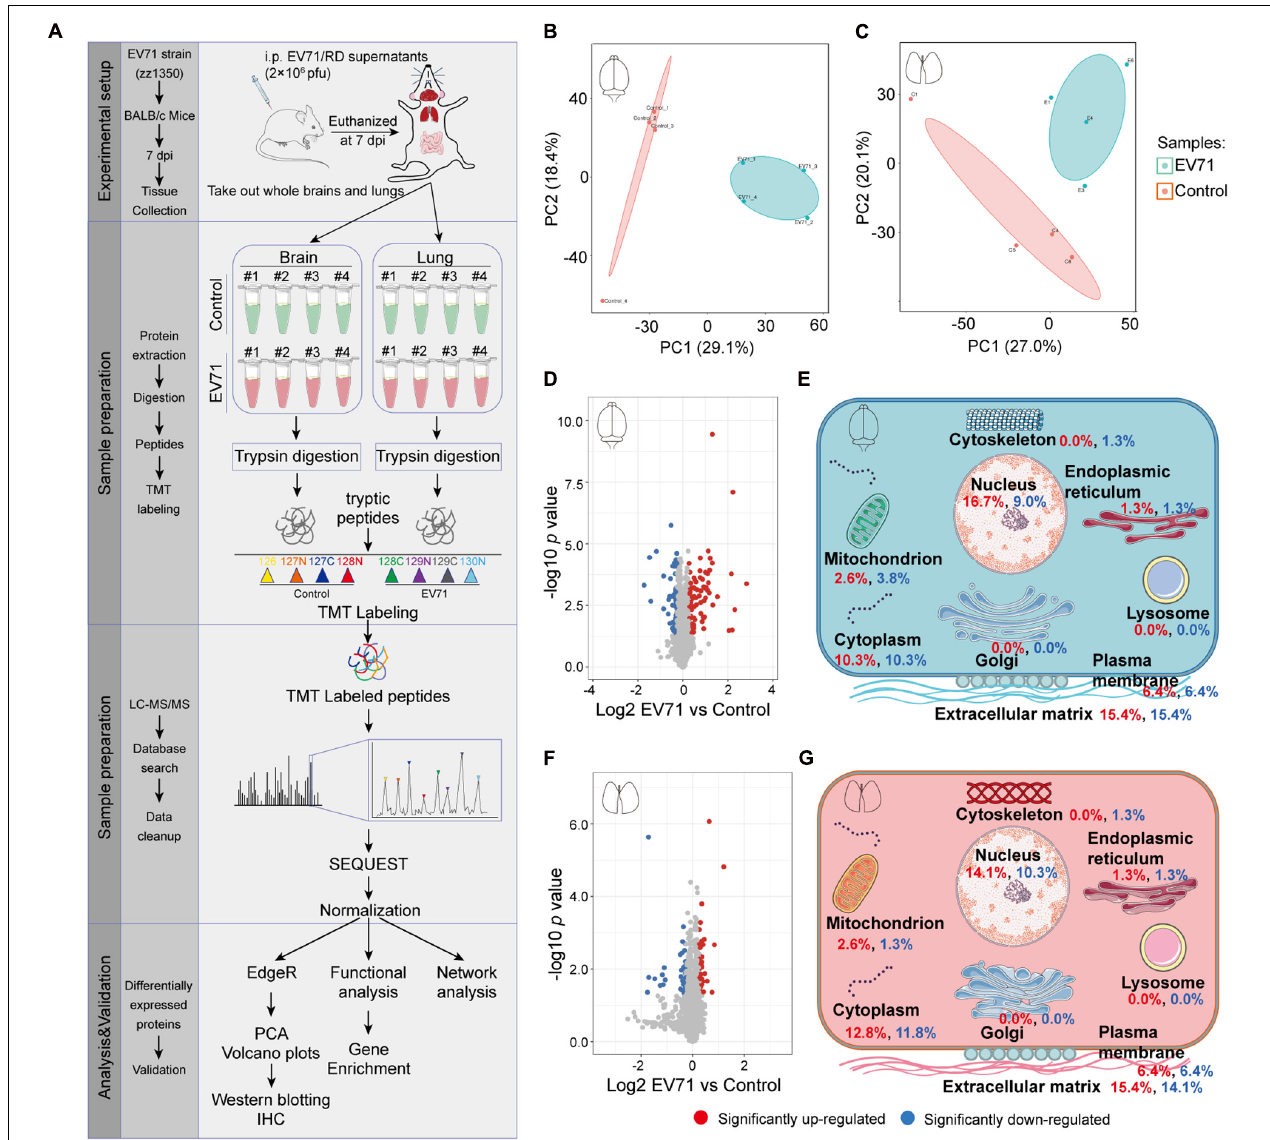
FIGURE 1 | The quantitative proteomic profile of EV71-infected brain and lung tissues. (A) Study design of quantitative proteomic analysis for EV71-infected brain and lung tissues. (B,C) Principal component analysis of the proteome profile. Biological replicates were generated for each sample, represented by different color points in the figure. (D,F) Volcano plots of the − log10 p value vs . the log2 protein abundance comparisons between brains or lungs from controls and those infected with EV71. Proteins outside the significance threshold lines ( p value < 0.05 and EV71/control > 1.2 or < 1/1.2) were colored in red (upregulated) or blue (downregulated). (E,G) Schematic of changes in the cell components of EV71-infected brain and lung tissues. Red and blue fonts represent up- and downregulated proteins detected in brain or lung tissues from EV71-infected mice compared to